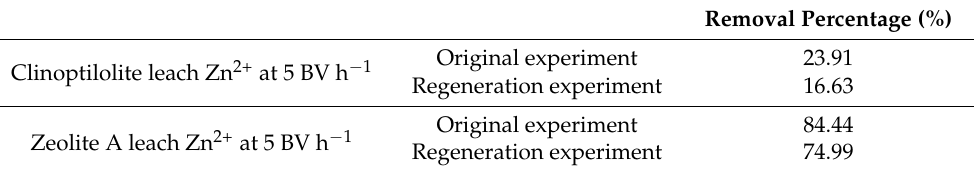
Table 1. The removal performances of the clean zeolites used to remove the heavy metal ions for the first time (Original experiment) and the regenerated zeolites used to remove the heavy metal ions (Regeneration experiment).